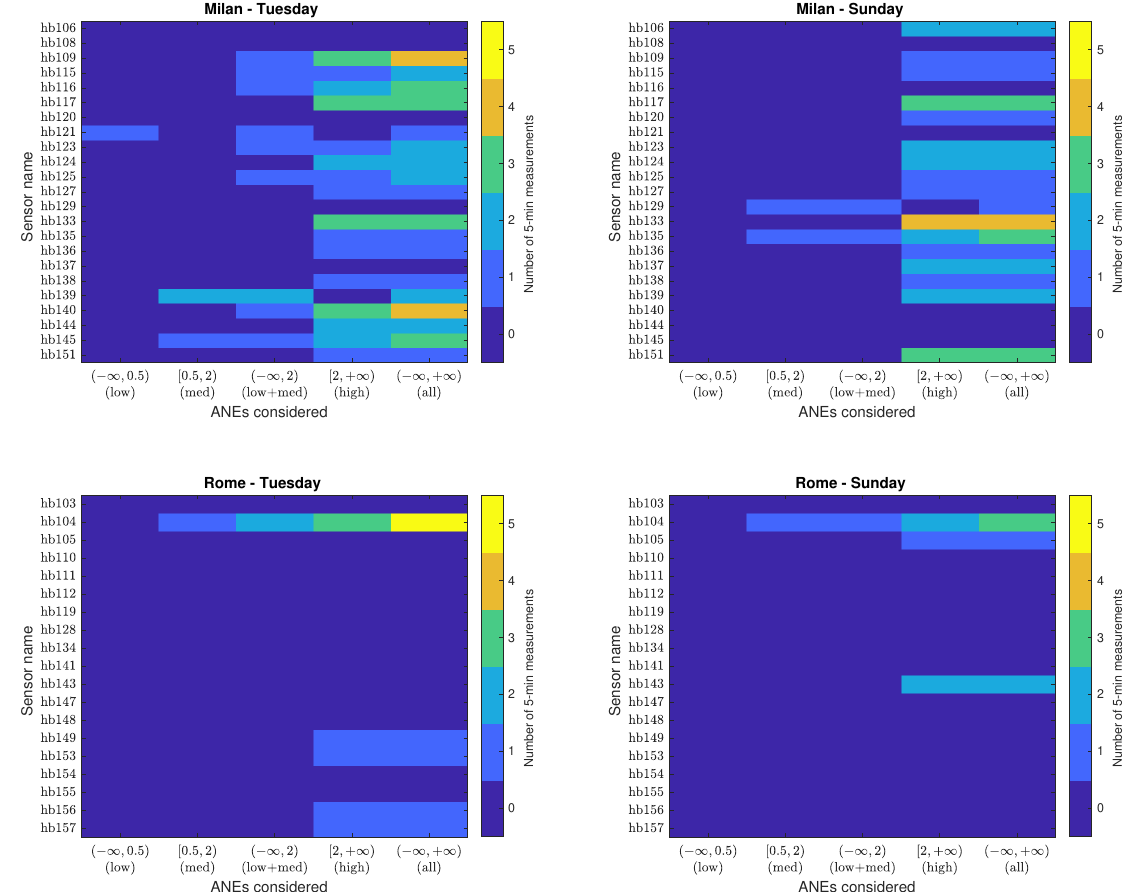
Figure 6. Critical AI histogram matrices ( H c ) categorized in the defined impact ranges for the urban (Milan) and suburban (Rome) environments obtained from a weekday (Tuesday) and weekend day